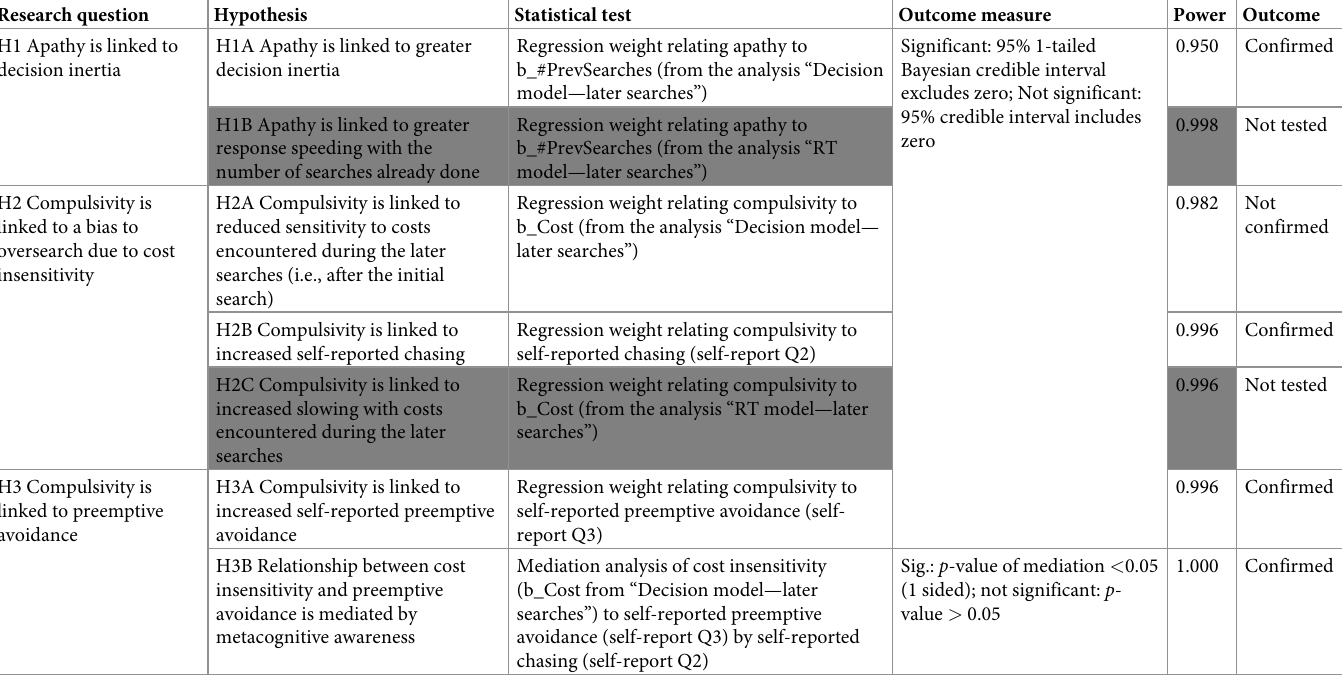
Table 4. Summary of the hypotheses and